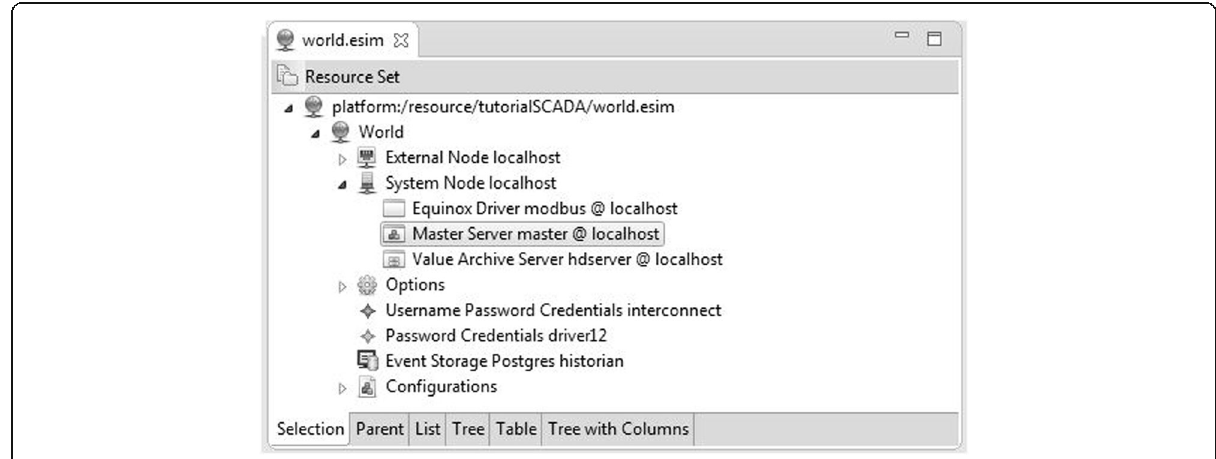
Fig. 5 EclipseSCADA configuration